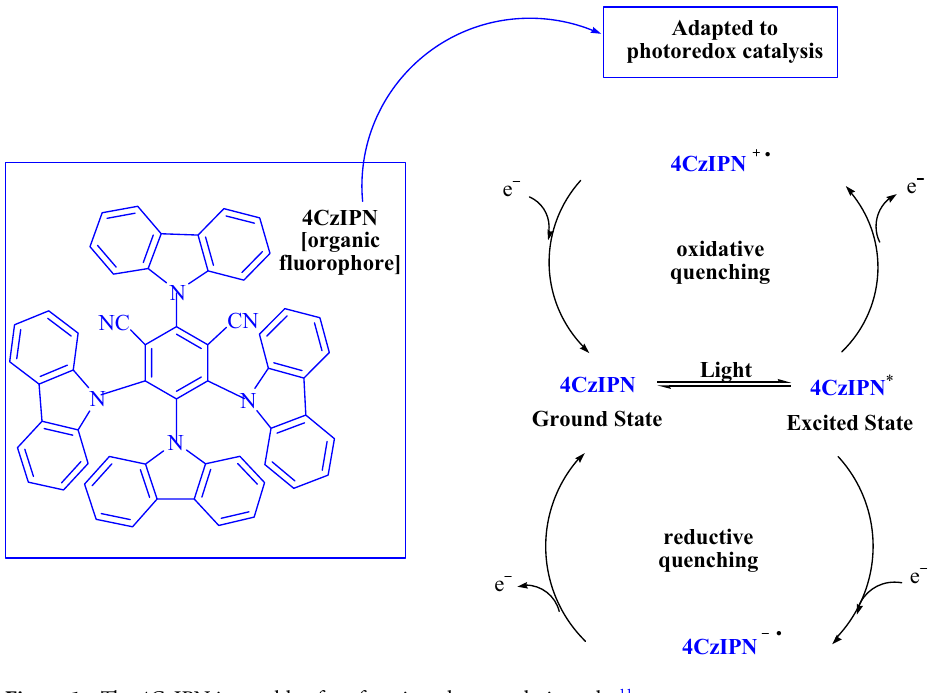
Figure 1. The 4CzIPN is capable of performing photocatalytic cycles 11